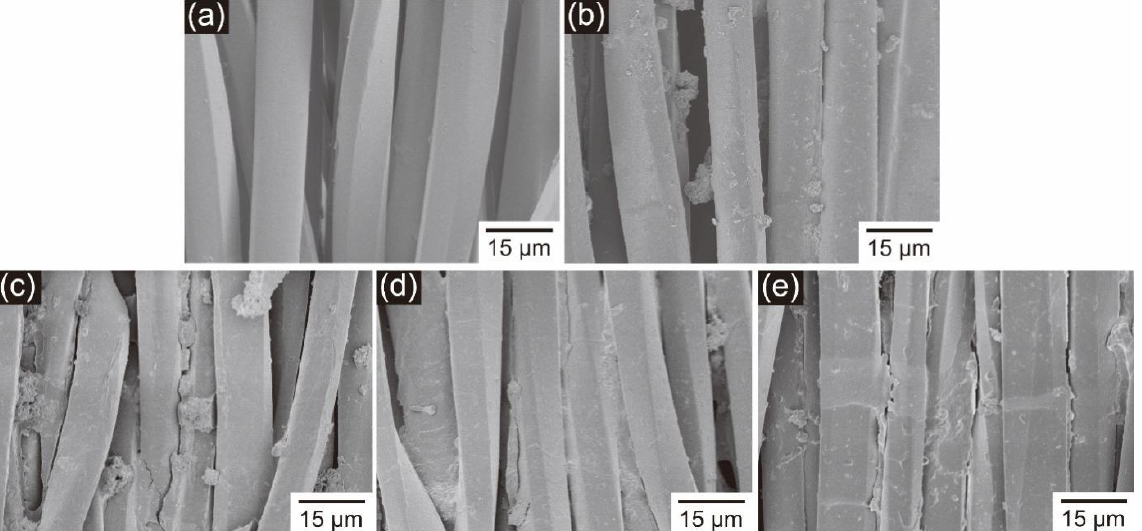
Figure 4. SEM images of fabrics: ( a ) polyester fabric, ( b ) polyester fabric printed with control sample, ( c ) polyester fabric printed with PVP ink, ( d ) polyester fabric printed with PVA ink, and ( e ) polyester fabric printed with PEG ink.